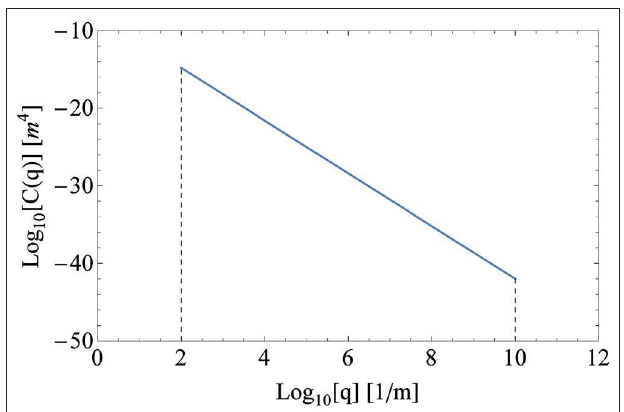
FIGURE 2 | Typical power-law PSD of a self-affine randomly rough surface. In this figure, Z 10 − 8 m 0.6 , with q 0 =